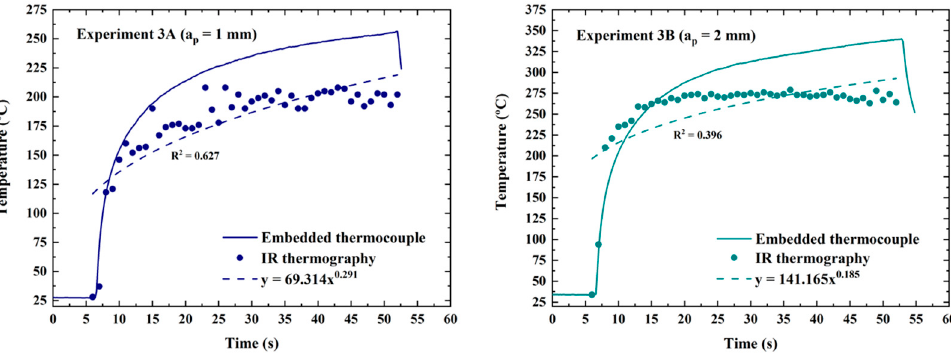
Figure 6. Effect of depth of cut variation on the tool temperature over the machining time (v c = 130 m/min).